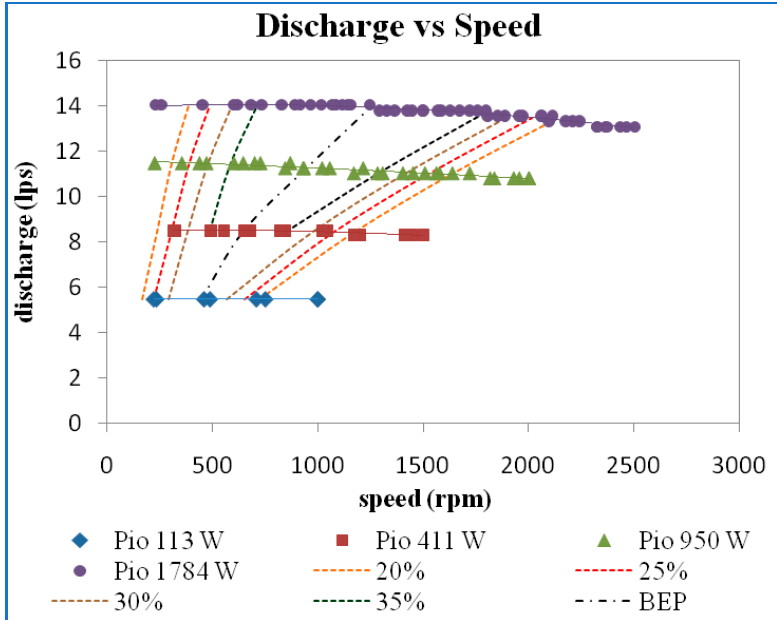
Figure 19. Discharge vs. speed and iso-efficiency line at 16 GVO.